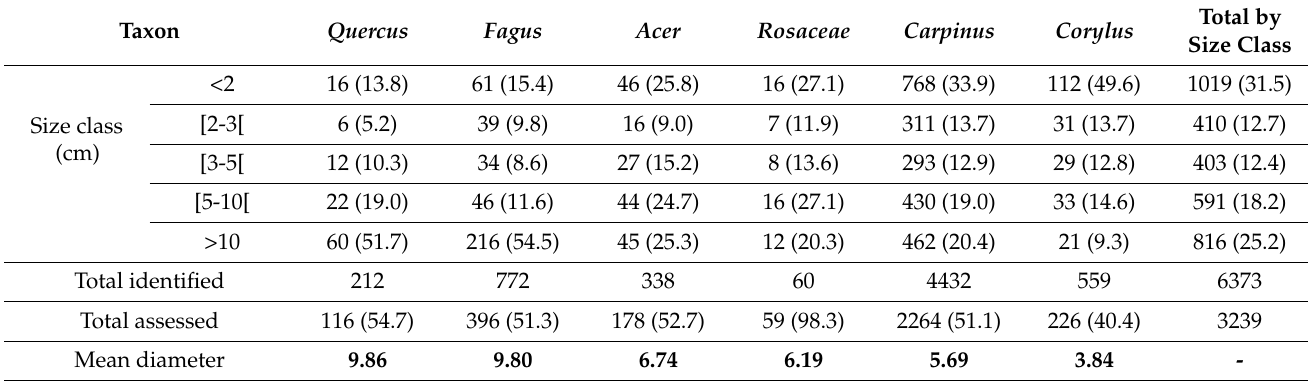
Table 2. Diameter estimation (cm) of the most frequent taxa, with absolute frequency and percentage of class size in brackets, ordered by decreasing mean diameter (in bold) for each taxon (complete dataset on Table